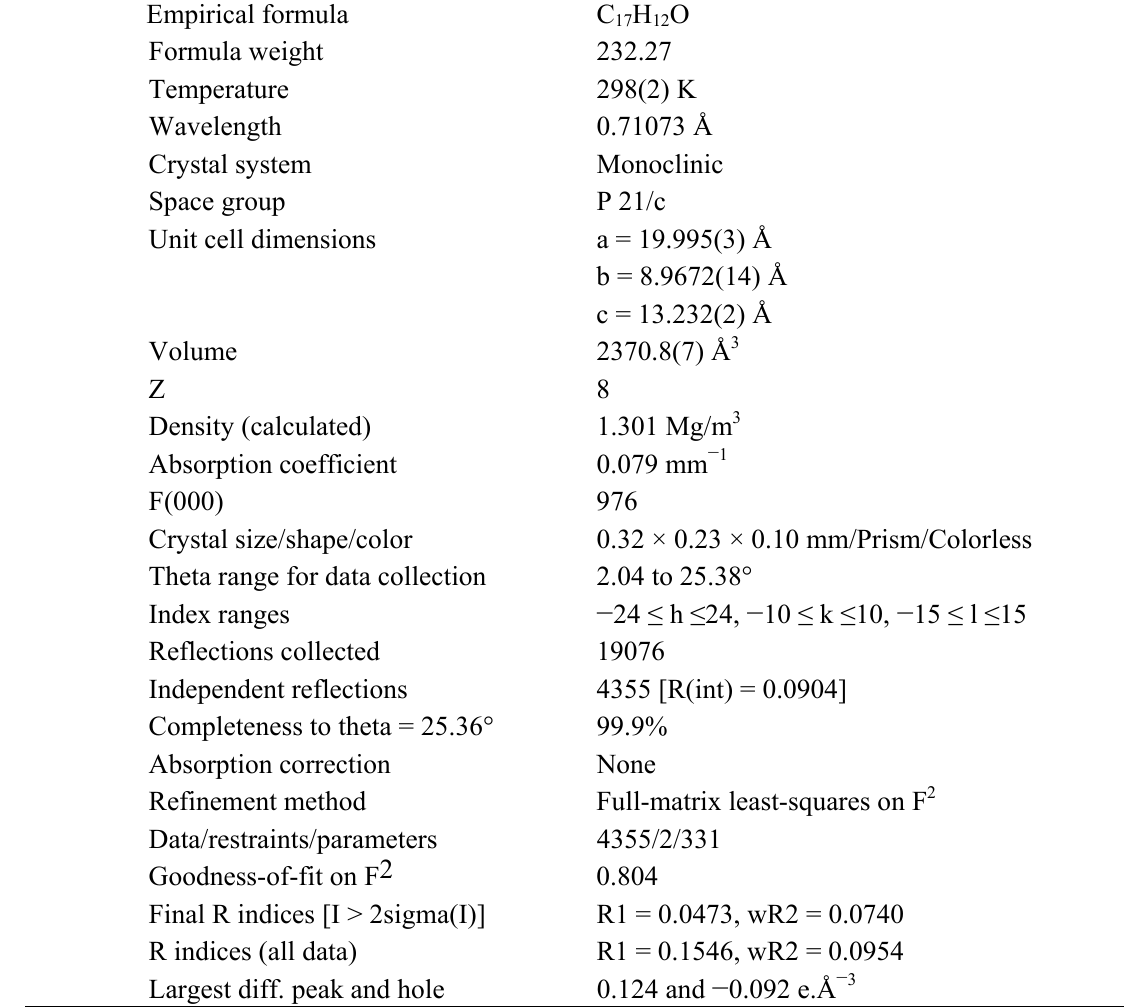
Table 3. Crystal data and structure